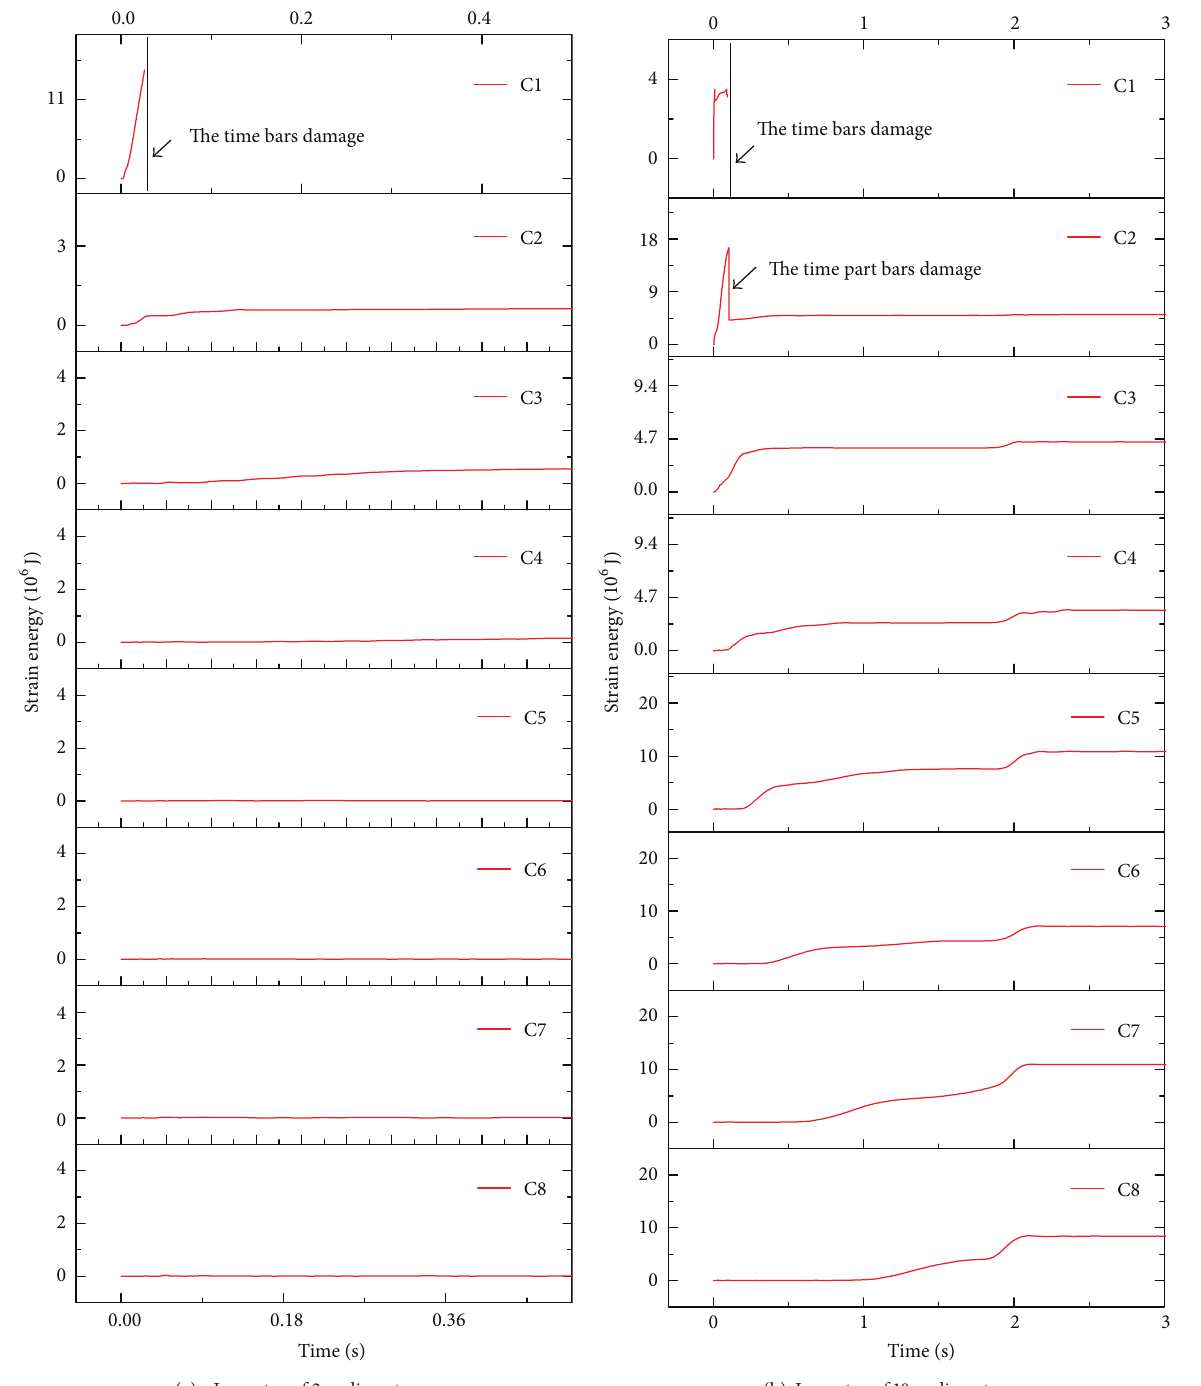
Figure 8: Time history of strain energy on two typical impact events with two different impactors and the same initial striking kinetic energy.